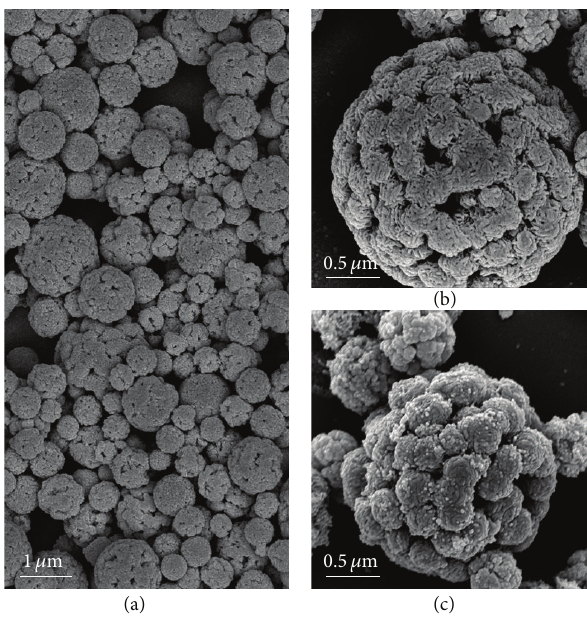
Figure2:TheFSEMimagesofCdIn 2 S 4 preparedbyultrasonicspray pyrolysis. (a) and (b) 500 ∘ C, (c) 700 ∘ C.